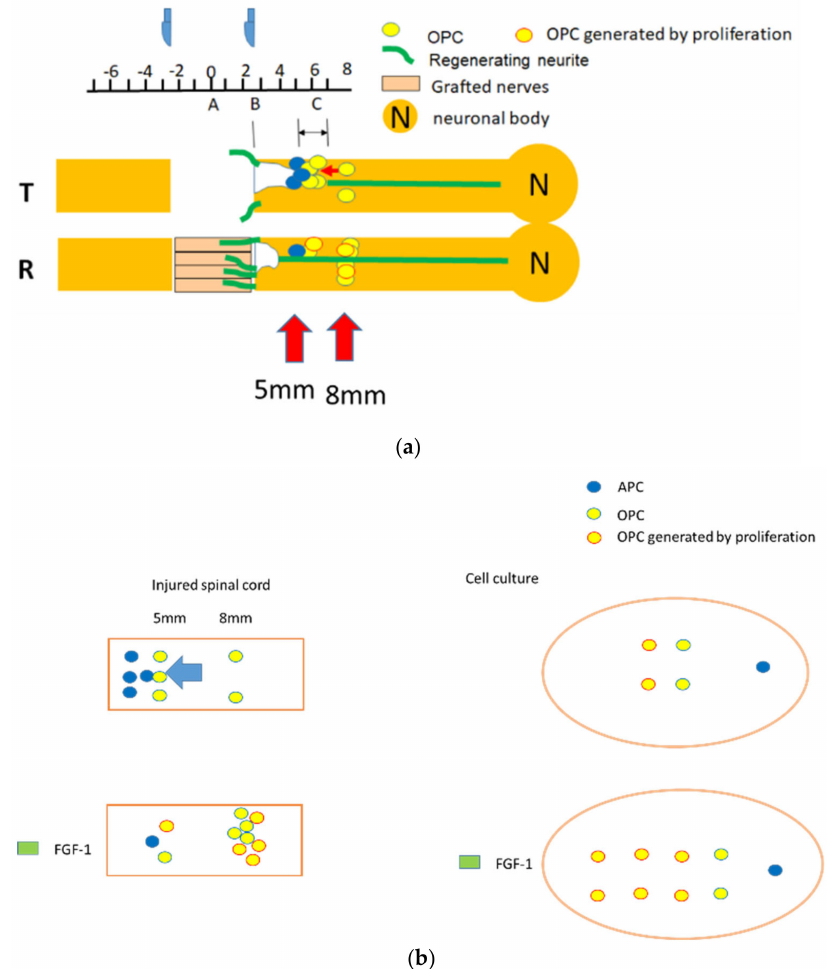
Figure 19. The OPC we saw in the transected rats may initially be migrated from neighboring area due to injury, while OPC migration did not significantly contribute to those observed in FGF-1-treated rats in the injury site ( a ). In the cell culture, the starting OPC cell number for the FGF-treated and non-treated cultures is similar; therefore, the cell number was only affected by the presence of FGF-1 and therefore was more in the FGF-1-treated culture ( b